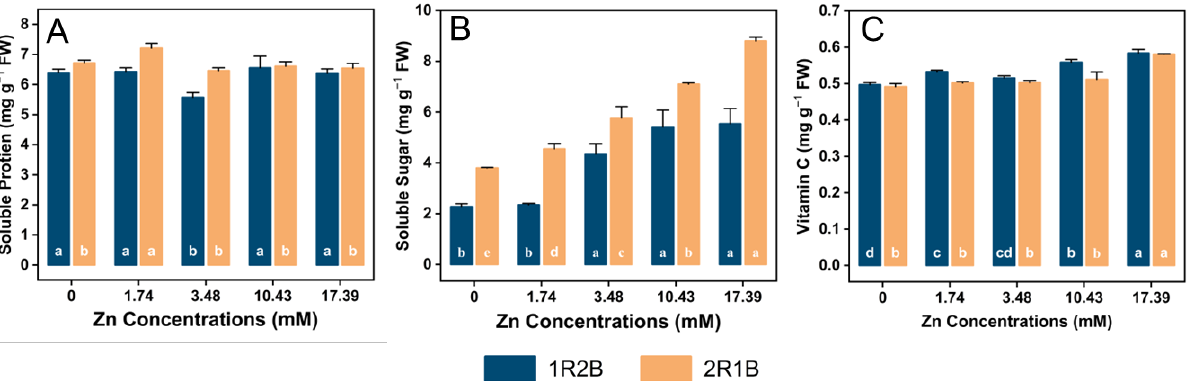
Figure 3. The contents of SP (soluble protein) ( A ), SS (soluble sugar) ( B ) and Vc (vitamin C) ( C ) of flowering Chinese cabbage sprouts (FCCS) grown combination of Zn concentration and R-B ratio (ratios of red and blue light). The letters marked in all figures indicate the significant difference under Zn treatments (p ≤ 0.05, Duncan’s test). Table 4. The interaction effects of SP (soluble protein), SS (soluble sugar) and Vc (vitamin C) in flowering Chinese cabbage sprouts (FCCS).